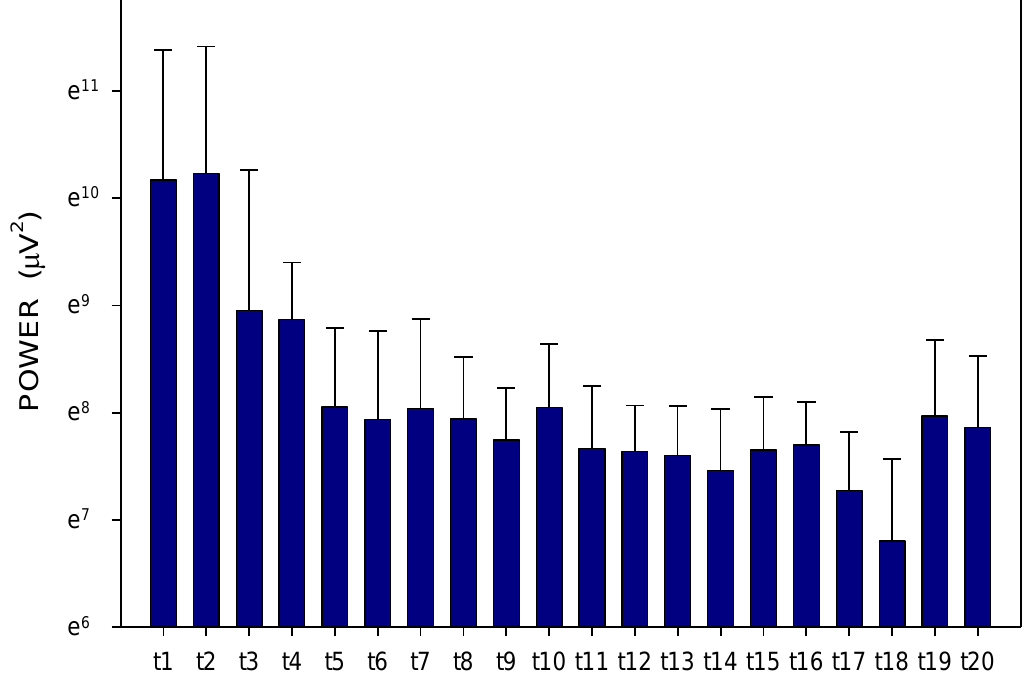
Figure 10. Electrogastrography. EGG power in animals with a longer small bowel transit time (486 ± 93 min); mean + standard deviation. Outliers omitted. Axis Y: natural logarithm scale. Explanatory note: t: 15-min study recordings after galantamine administration (t1: time interval between 0–15 min ... t20: time interval between 286–300 min).